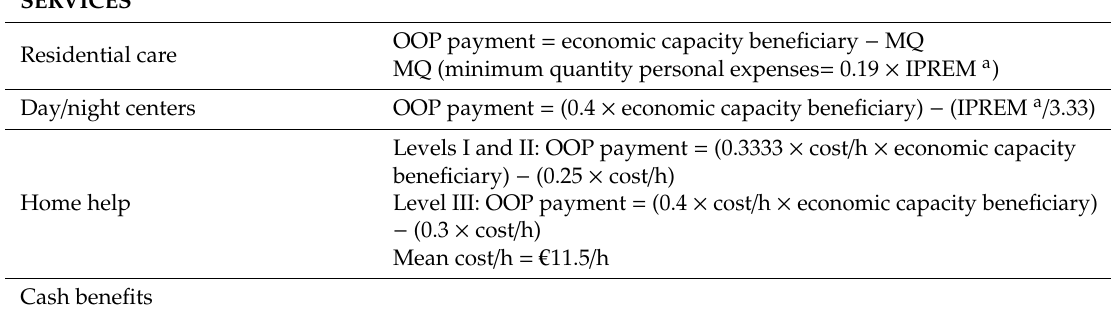
Table 3. Beneficiary out-of-pocket (OOP) payments by type of dependent care benefit in euros 2012.